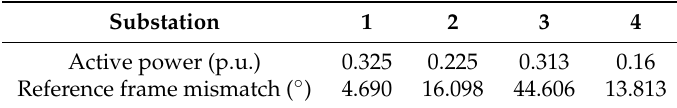
Table 3. Parameters of configuration where error indicator J 2 =